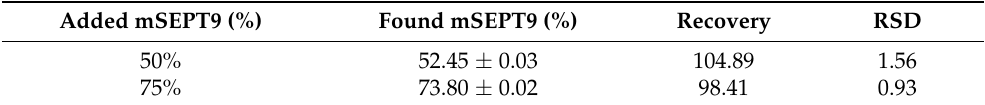
Table 4. Application mSEPT9 in commercial human serum.